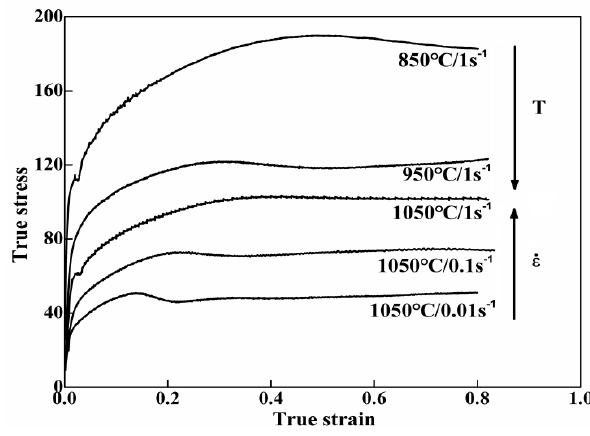
Figure 3 . True stress–strain curves of 35CrMo steel at different deformation conditions. Figure 3. True stress–strain curves of 35CrMo steel at different deformation